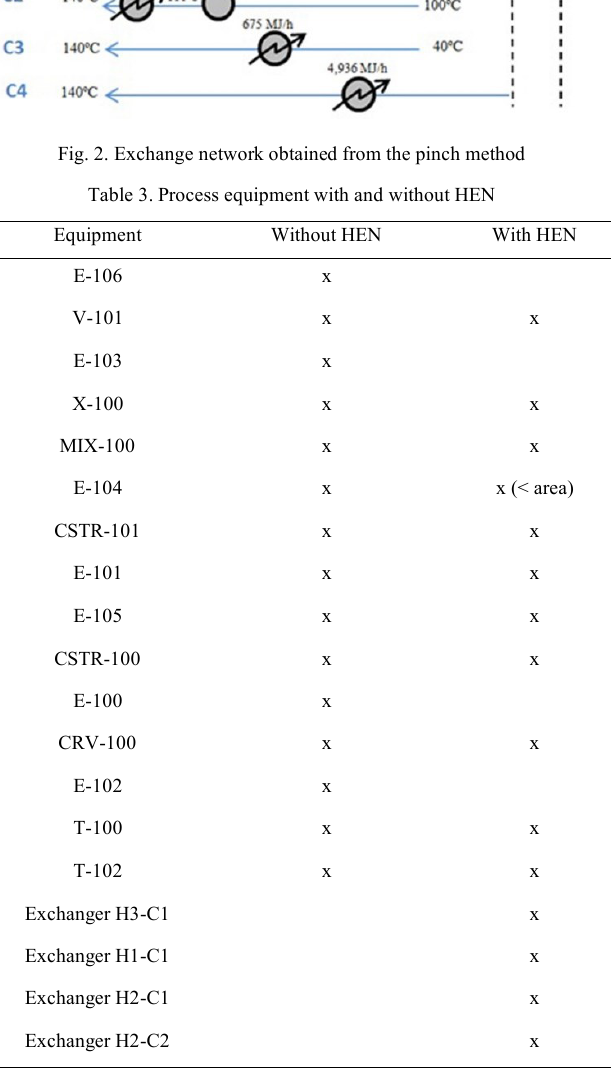
Table 4. Capital investment of different equipment in the processes with and without HEN